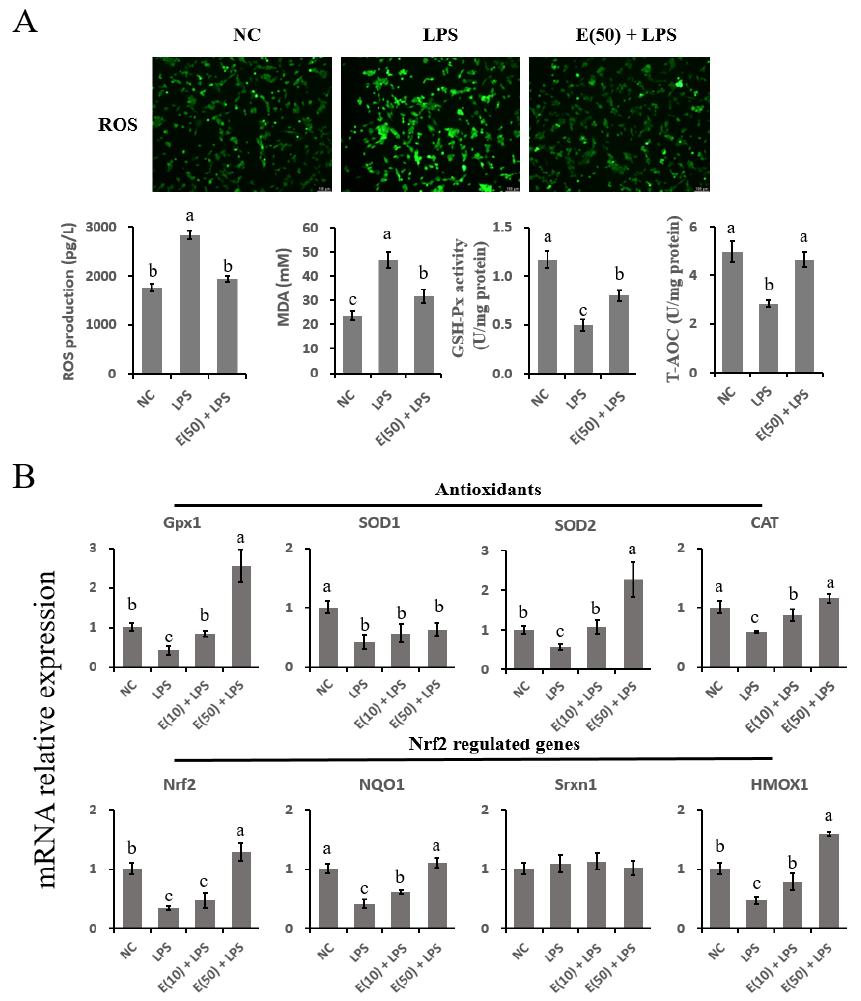
enhanced ROS production as demonstrated by increased staining of intracellular ROS and concentrations of ROS or MDA in the LPS group. However, pretreatment with 50 µ M EGCG inhibited the accumulation of ROS and MDA induced by LPS challenge. Regarding antioxidant enzyme activity, GSH-Px and T-AOC activity were reduced by LPS stimulation, whereas EGCG pretreatment improved the antioxidant capacity by increasing the GSH-Px activity and T-AOC compared to the LPS group ( p < 0.05).